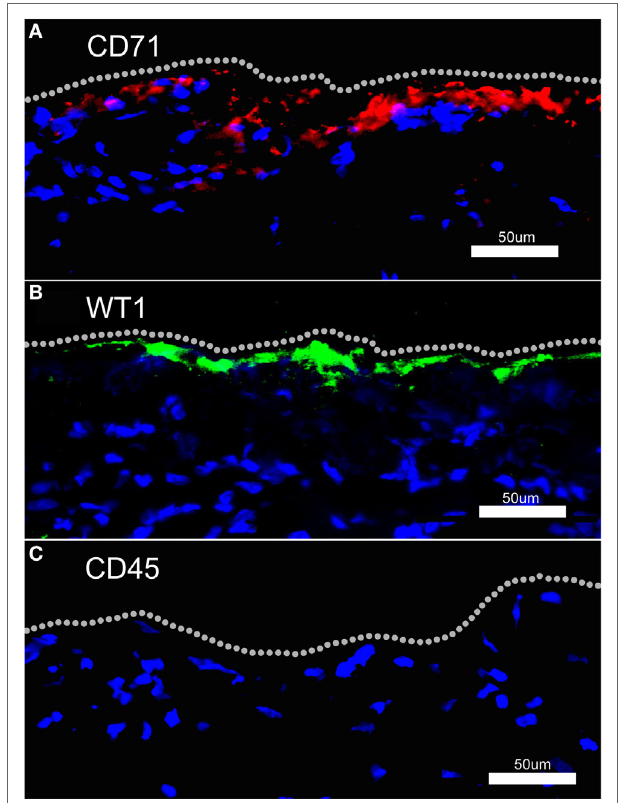
FigUre 3 | Fluorescence immunohistochemistry of human pleural mesothelium. Human pleura, obtained from surgical specimens, was stained with fluorochrome-labeled anti-CD71 (a) , anti-WT1 (B) , and anti-CD45 (c) monoclonal antibodies and counterstained with Hoechst 33342. Both anti-CD71 and anti-WT1 antibodies demonstrated discontinuous staining of the pleural mesothelium. There was no detectable pleural staining with labeled anti-CD45 monoclonal antibody. Bar = 50